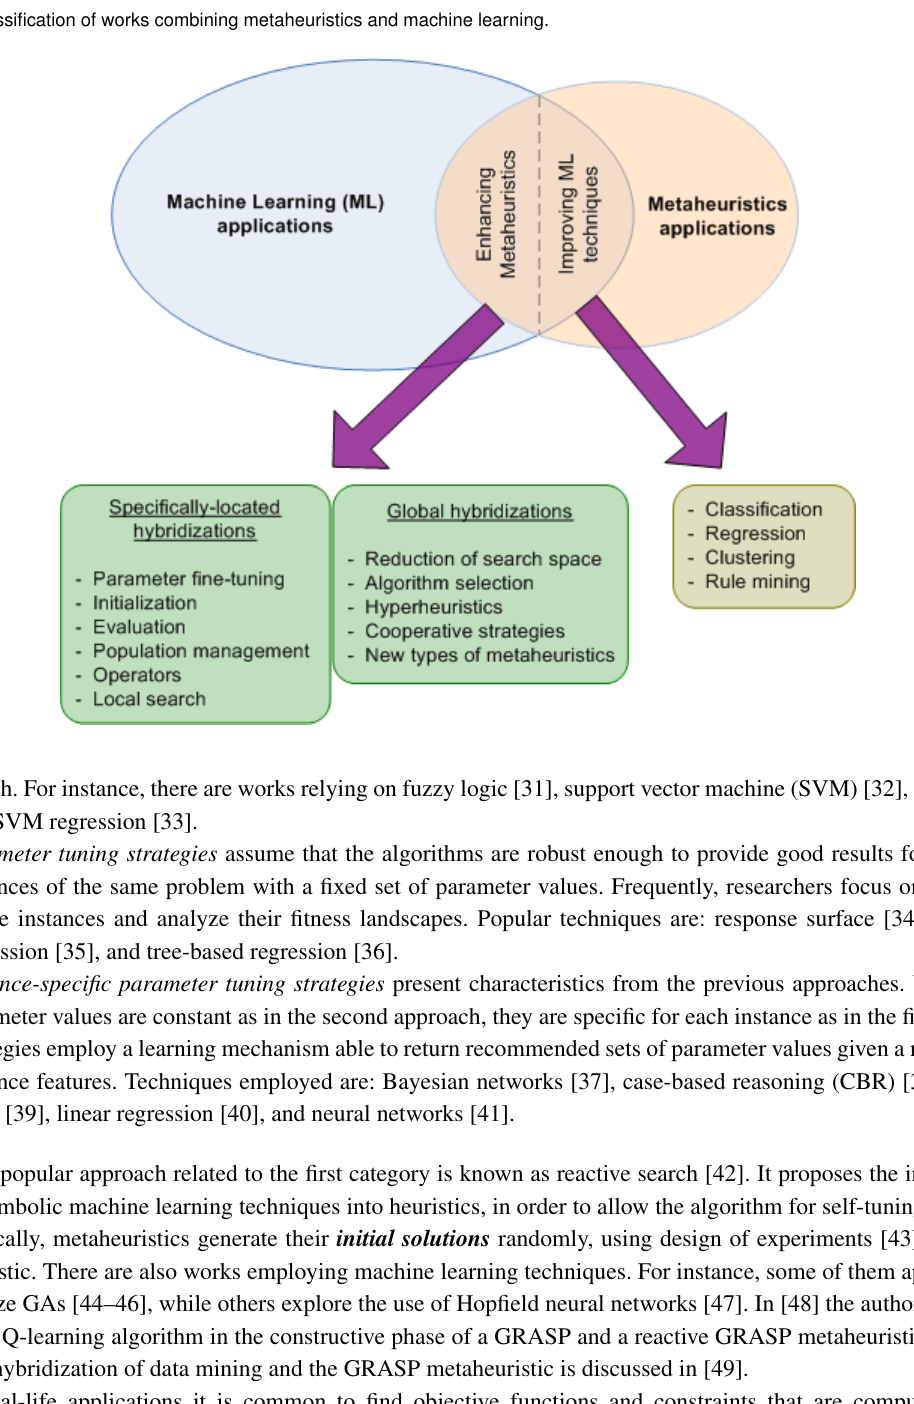
Fig. 4. Classification of works combining metaheuristics and machine